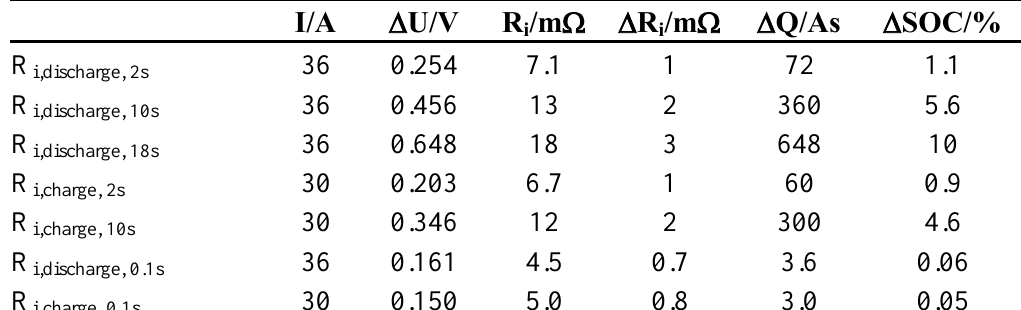
Table 1. Internal resistance of the NX2P0M cell, measured according to VDA procedure and the optimized